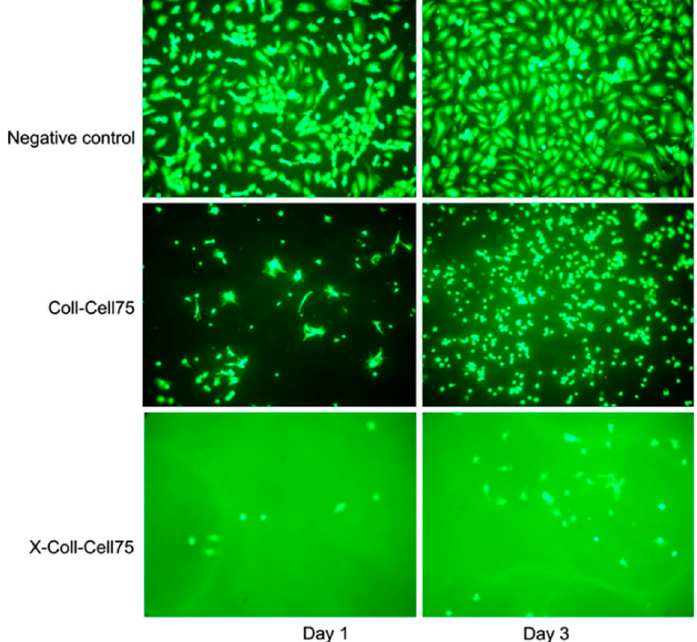
Figure 5. Cell adhesion and growth on the nanocellulose hydrogel compared to the negative control. X: Cross-linker agent, Coll: Collagen, Cell75: 75 wt% of nanocellulose The figure above was adapted with permission from the cited reference [81].